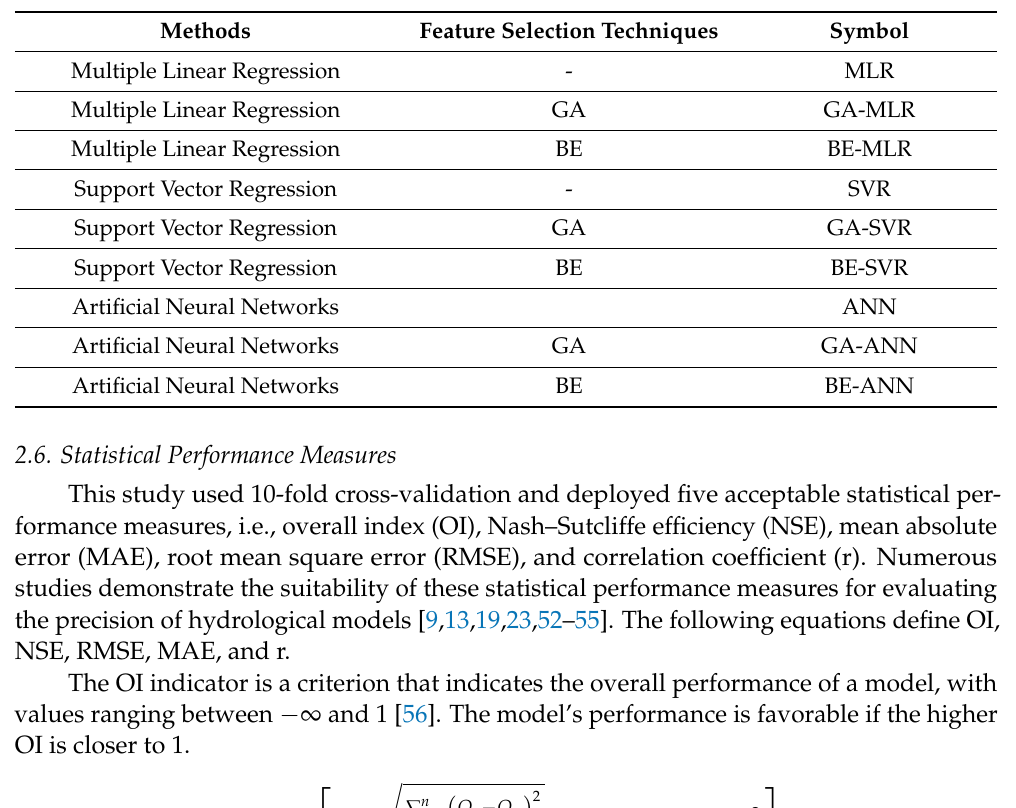
Table 4. The experimental